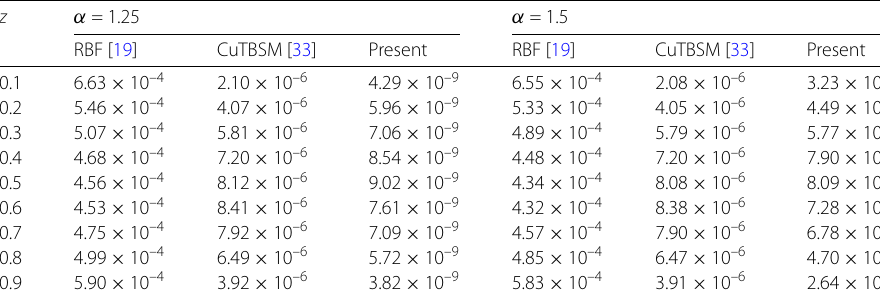
Table 6 Approximate results when N = 50 at t = 1 for Example 3 z α = 1.25 α =